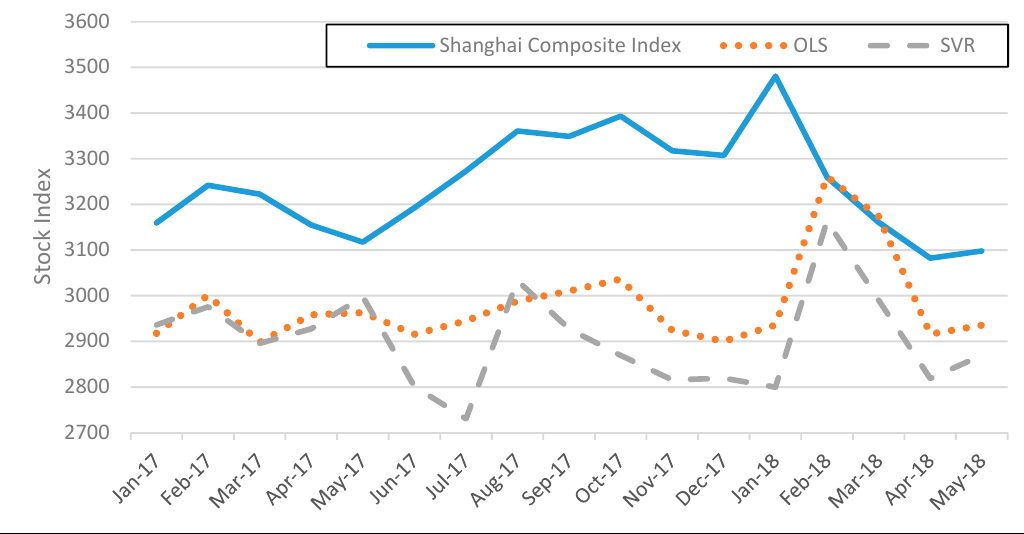
Figure 7. Out-of-sample 12-month ahead exchange rate forecasts for the Shanghai Composite index based on the GPR index for the SVR and OLS model for the period Jan-2017 to May-2018.